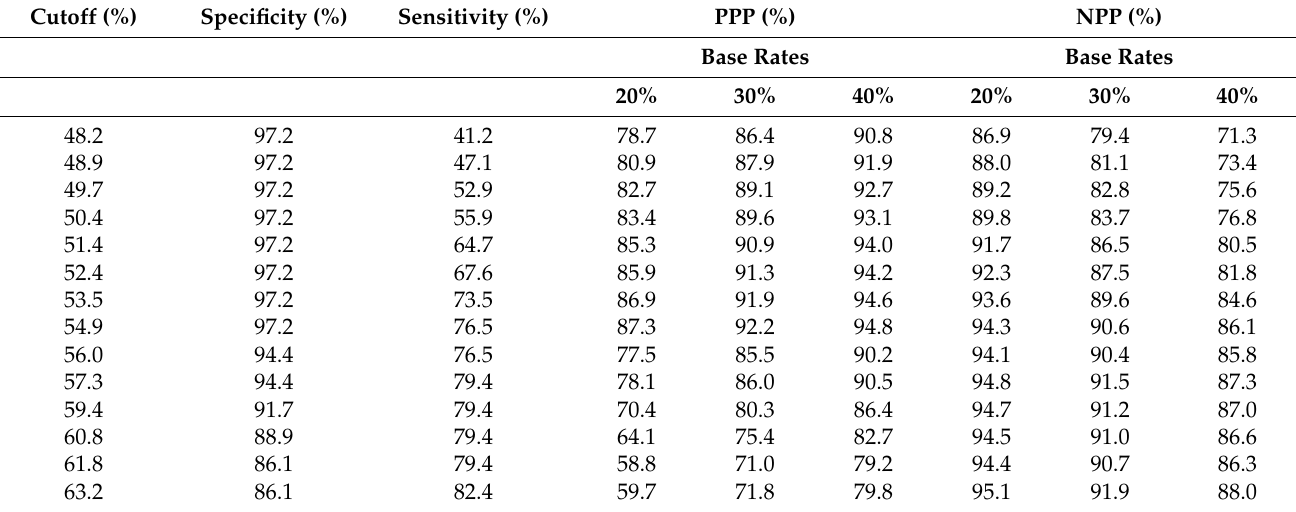
Table 2. Classification accuracy based on utility estimates (specificity/sensitivity/PPP/NPP values) of the MPMT’s primary outcome measure (% correct